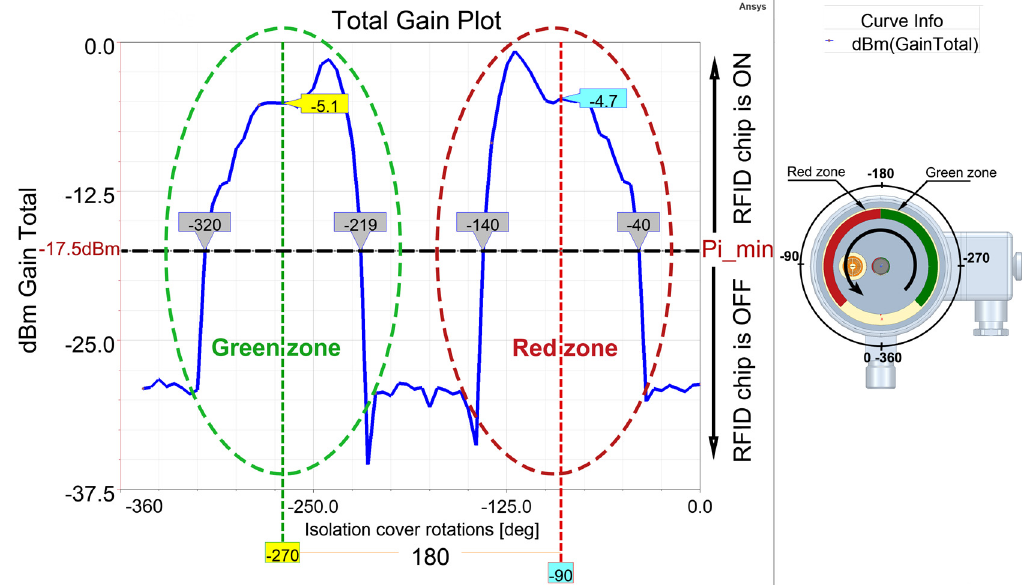
Figure 10. RFID tag total gain and switching angles.